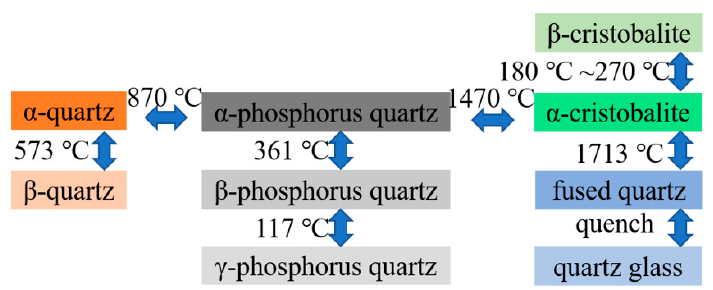
Figure 2. SiO 2 crystal transformation diagram under different conditions.